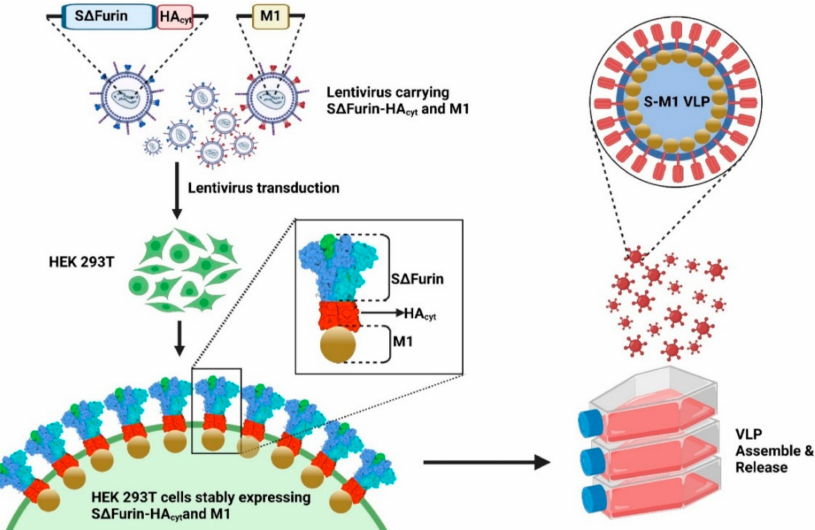
Figure 1. Development of a cell line for the production of chimeric SARS-CoV-2 VLP. Lentiviruses carrying either a SARS-CoV-2 S gene with a deletion of the RRAR motif ( ∆ Furin) and fused to an influenza virus HA transmembrane and cytoplasmic tail (HA cyt ), or an influenza A M1 gene were used to transduce HEK293T cells. The resulting HEK293T cells express S on the cell surface, and associate with M1 proteins. The M1 proteins induce the cell membrane budding, resulting in the release of S-M1 VLP into the cell culture supernatant while the cell line is maintained in culture.